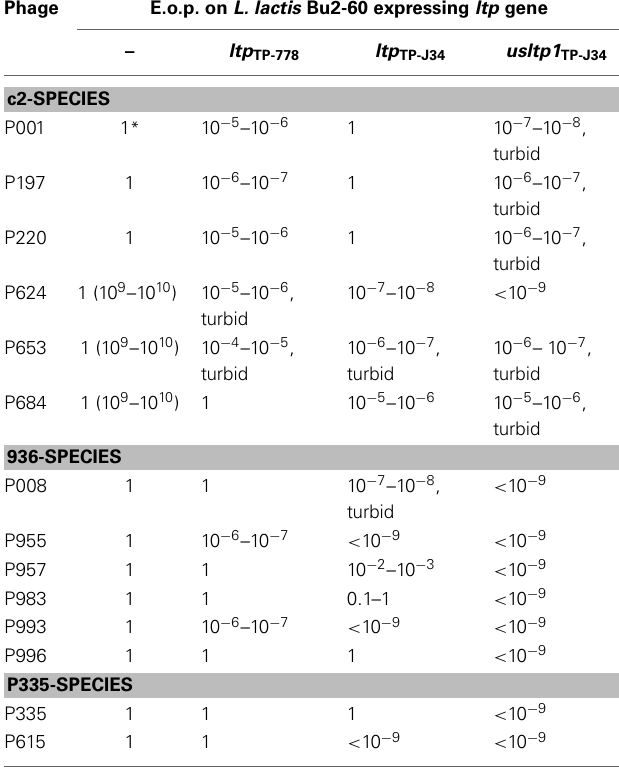
Table 6 | Semi-quantitative spottest for estimating the effects of different Ltp-proteins on infection of L. lactis Bu2-60 by different